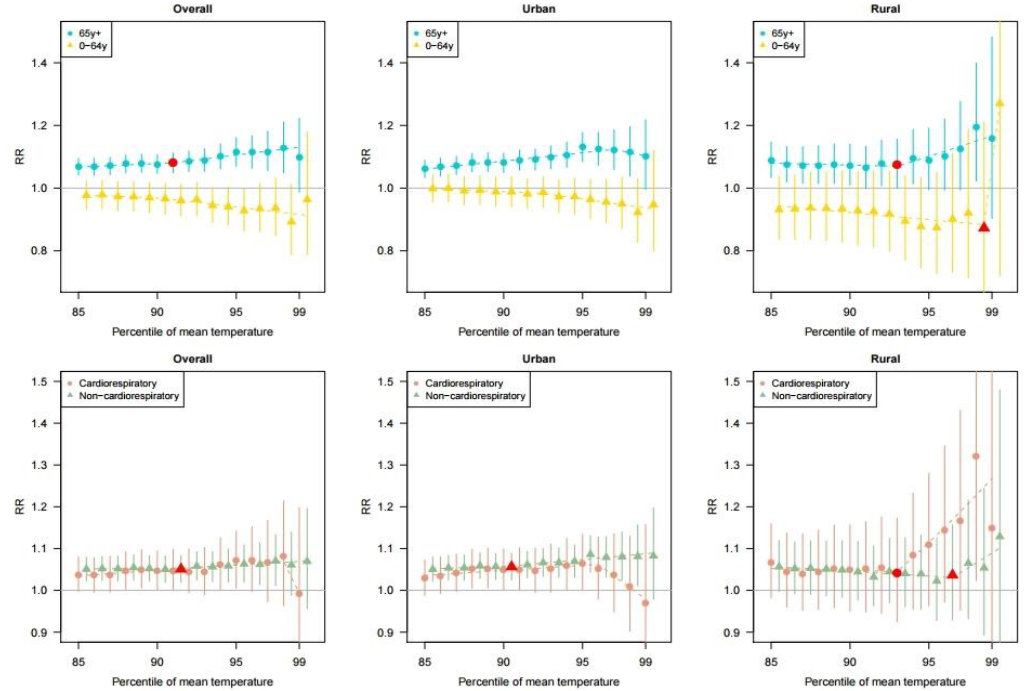
Figure 3. Age-specific and mortality cause-specific associations between the percentile of the mean temperature and pooled heatwave-related mortality risk (RR) in the total, urban, and rural areas with 95% confidence interval (vertical lines). The dashed line indicates the relative risk based on the piecewise regression (a V-shape regression) model. The red points indicate the estimates at the threshold points. The threshold points were excluded if the slope after the threshold point was negative.